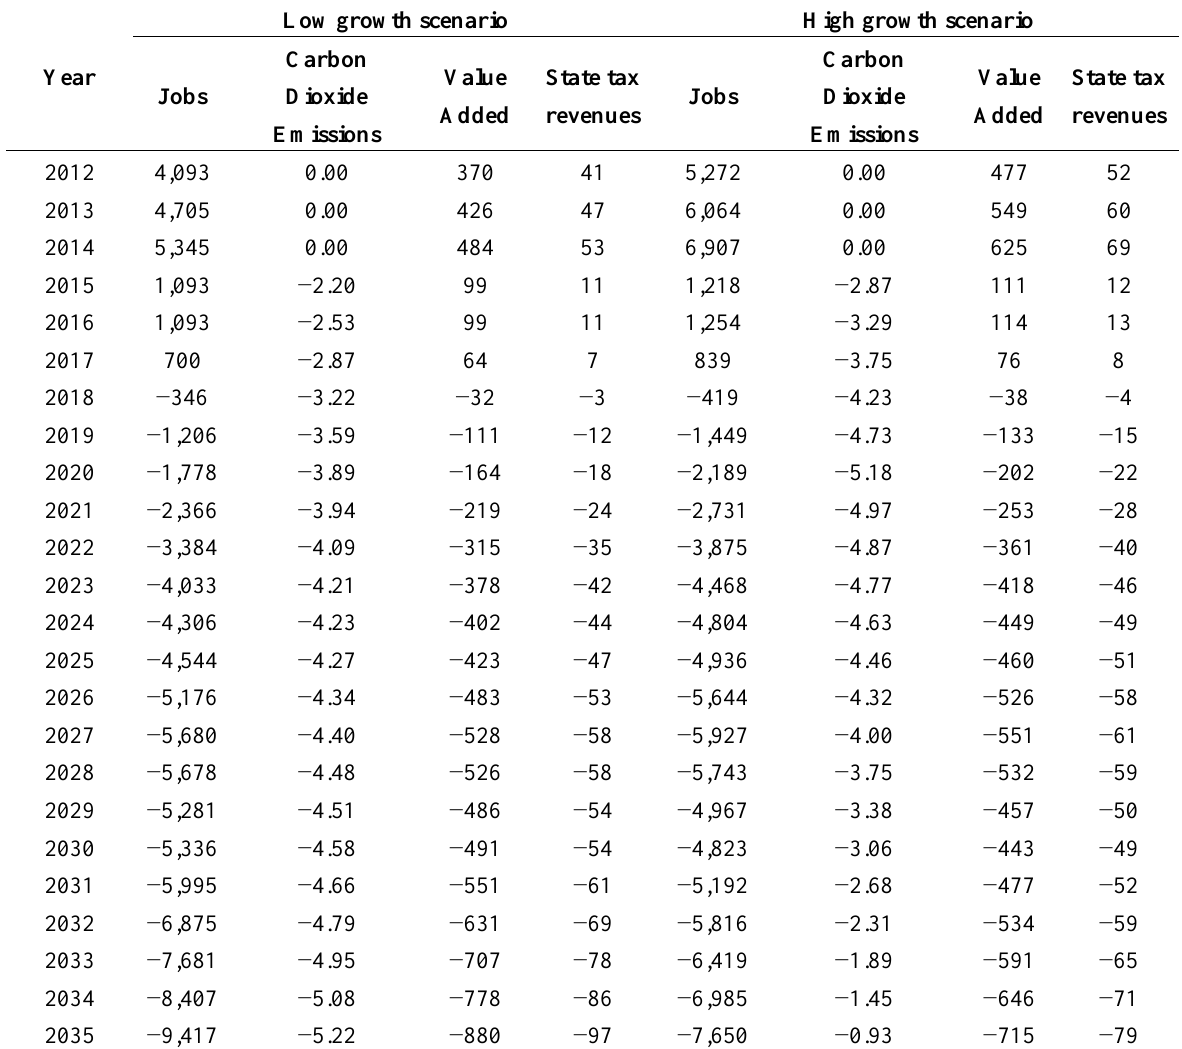
Table 4. Net economic and environmental impacts from natural gas